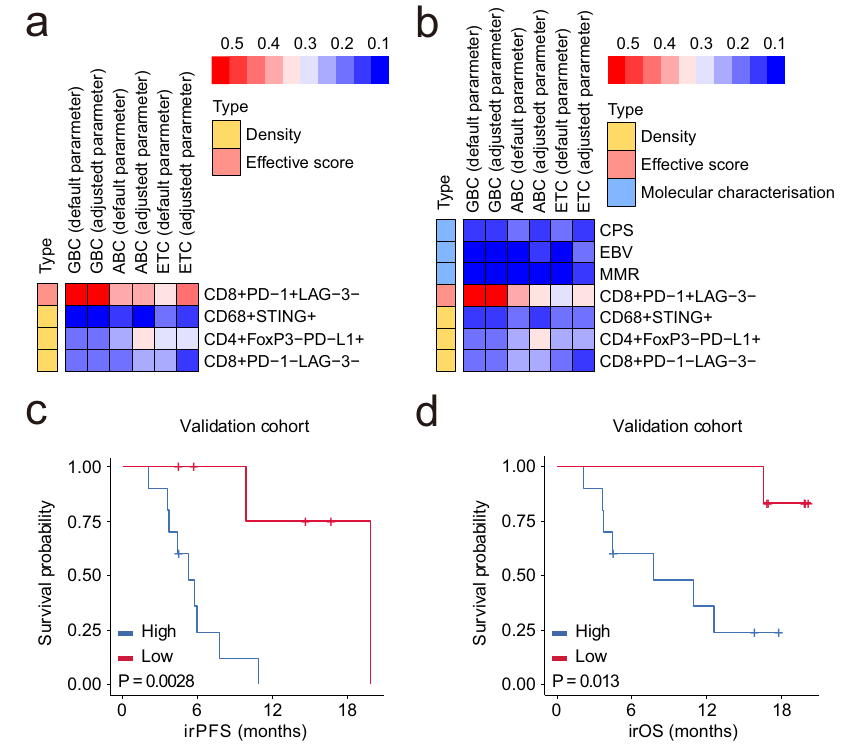
Fig. 5 | Feature importance of the TIIC signature and predictive value of the TIIC signature in immune-related survival. a , b The feature importance of each marker in the prediction model. c , d Kaplan – Meier curves of the ( c ) immune- related progression-free survival (irPFS) and ( d ) immune-related overall survival